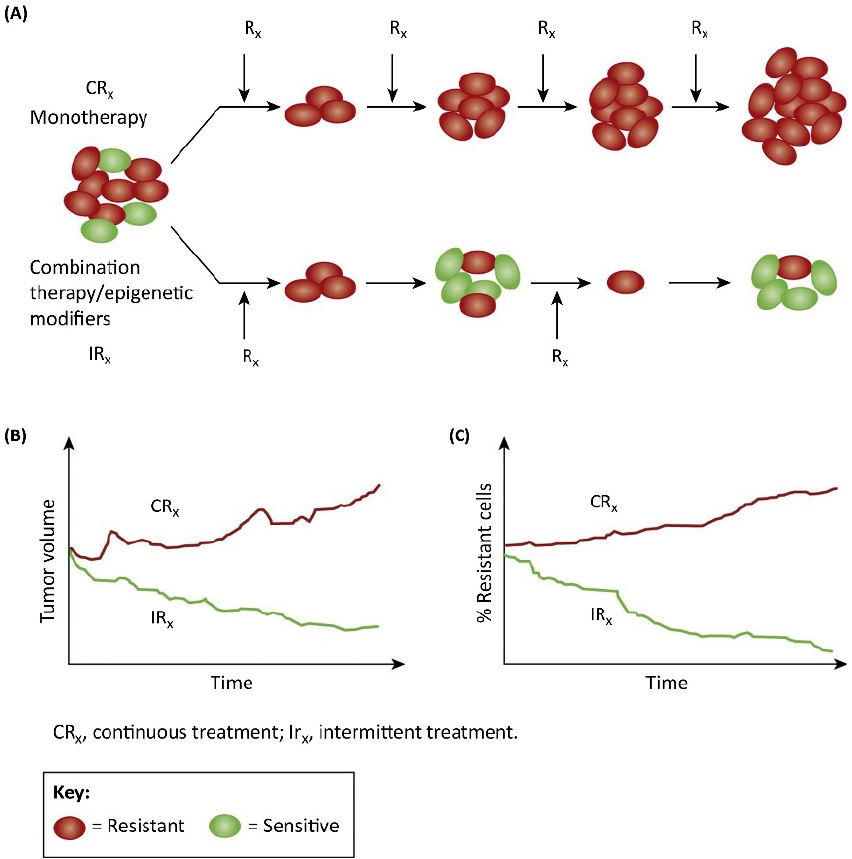
Figure 3. Continuous Monotherapy versus Intermittent Combination Therapy. ( A ) In continuous monotherapy, the idea is to eradicate the tumor as quickly as possible. However, this strategy can give rise to resistance, and resistant cells are expected to propagate over time (top). By contrast, combination therapy applied intermittently (bottom) could induce ‘adaptive strategies’ to change the tumor environment in such a way that the proliferation of the resistant clones can be suppressed for prolonged periods of time. Therapy is applied in small doses to reduce the tumor population only sufficient enough to improve the symptoms. Furthermore, treatment is intermittent so that drug-sensitive cells will proliferate at the expense of the resistant ones. ( B , C ) Although the tumor will increase in size between treatments, the extant tumor cells will continue to be sensitive to therapy [21].